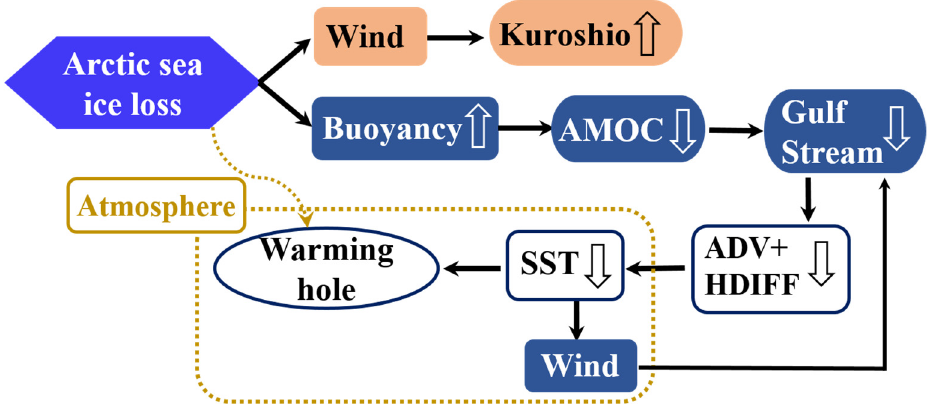
Figure 11. Schematic diagram showing the mechanisms for the Gulf Stream and Kuroshio responses to Arctic sea ice loss, a series of ocean adjustments, and the atmospheric teleconnections. Supplementary Materials: The following supporting information can be downloaded at: https: www.mdpi.com/xxx/s1, Figure S1: The annual mean of longwave radiative flux (W/m 2 ) artificially added to the sea ice model in ICE_21 compared to ICE_20. The direction of longwave radiative flux is downward.; Figure S2: The average of 6–25 year response of SST to Arctic sea ice loss in FOM. Values not significant at the 95% confidence level are hatched.; Figure S3: Temporal evolutions of the responses to Arctic sea ice loss in FOM. The black curve is for the AMOC index; the green for potential density (kg/m 3 ); the orange for salinity (psu); the red for potential temperature (°C). The right y-axis is for the AMOC index, and the left, for the other variables. All variables, except for the AMOC index, are averaged over the box of 56°–62° N, 50°–58° W and 0–200 m in the Labrador Sea.